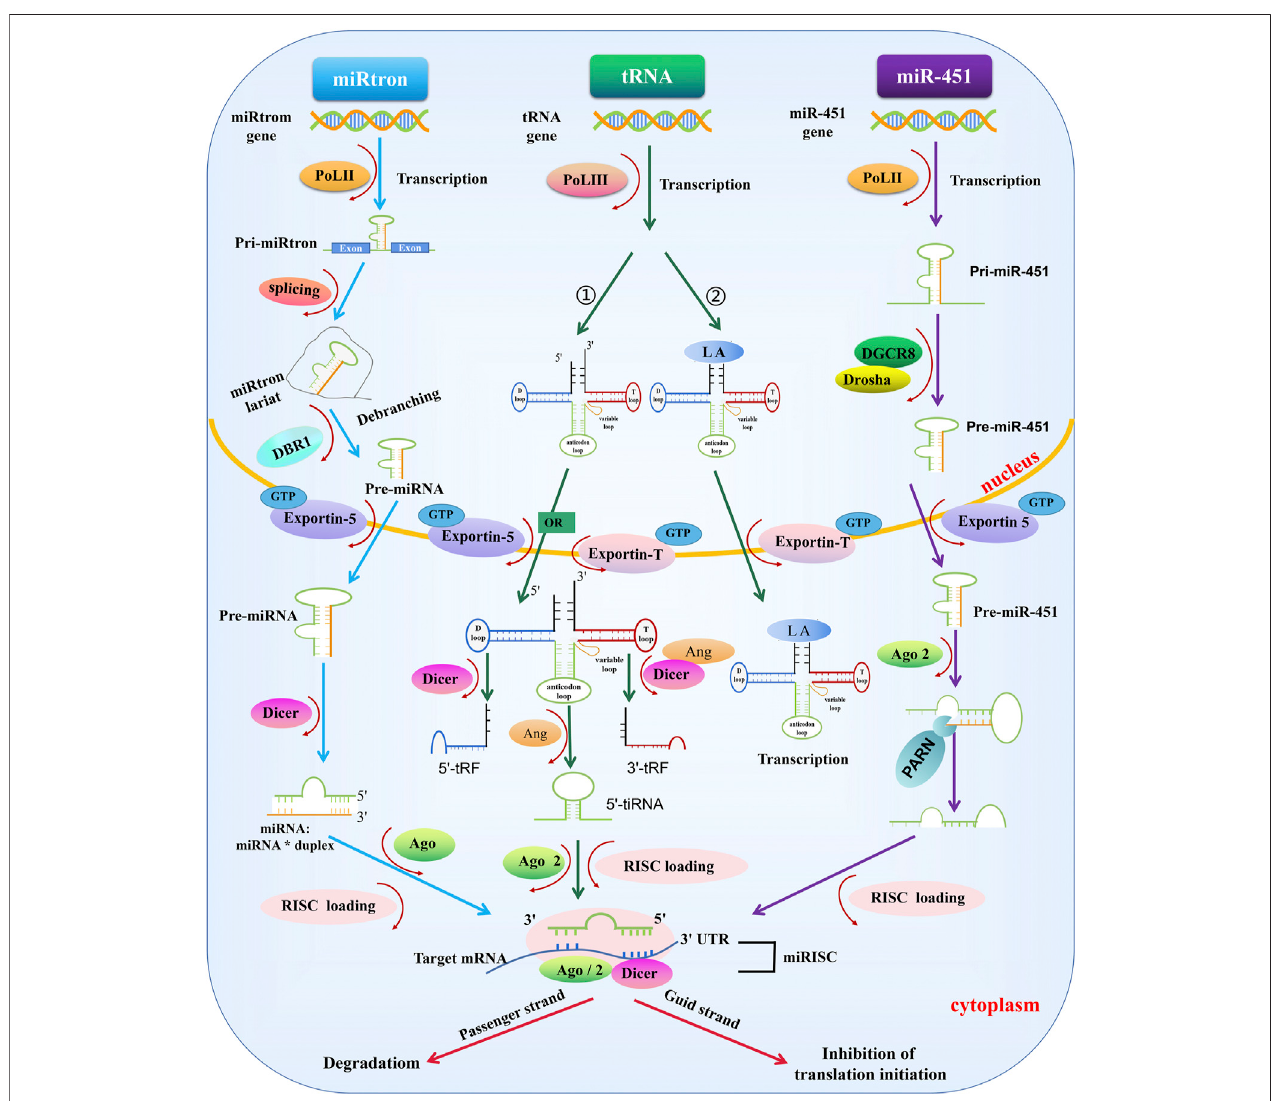
FIGURE 2 | Biogenesis of non-canonical miRNAs. miRtrons: miRtron are primarily localized in the introns of host genes and modi fi ed introns, which are formed by the spliceosome and lariat debranching enzyme 1 (DBR1) treatment in the nucleus, can act as pre-miRNAs — which are processed independently of DROSHA/DGCR8. TheremainingmiRtronbiosynthesisprocessisthesameascanonicalmiRNAs.tRNA:1)tRNAstartsfromPOLIIIintheearlystage.Next,thepre-tRNAisexportedtothe cytoplasmbyExportin-5orExportin-T.Inthecytoplasm,thepre-tRNAadoptsacloverleaf-shapedsecondarystructure,composedofaD-loop,ananticodonloop, a T-loop, and a variable loop. Pre-tRNA is cleaved by Dicer or angiogenin (ANG): the h D-loop is cleaved by Dicer, the T-loop is cleaved by Dicer and ANG, and the anticodon loop is cleaved by ANG. Some tRNA fragments are loaded into RISC containing AGO2 protein and regulate gene expression. 2) tRNAs transcribed and synthesized by POL III can be stabilized by LA and transported to the cytoplasm under the action of Exportin-T and Ran GTPase to maintain the stability of tRNAs for translation.MiR-451:MiR-451 intranscribedbyPOLII.Aftermodi fi cation byDROSHA/DGCR8treatment,miR-451isexported tothecytoplasmbyExportin-5 and Ran GTPase, cleaved by an unknown endonuclease at the 3 ′ end, and loaded into the RISC-AGO complex to exert its biological function, a process independent of Dicer enzymatic cleavage.